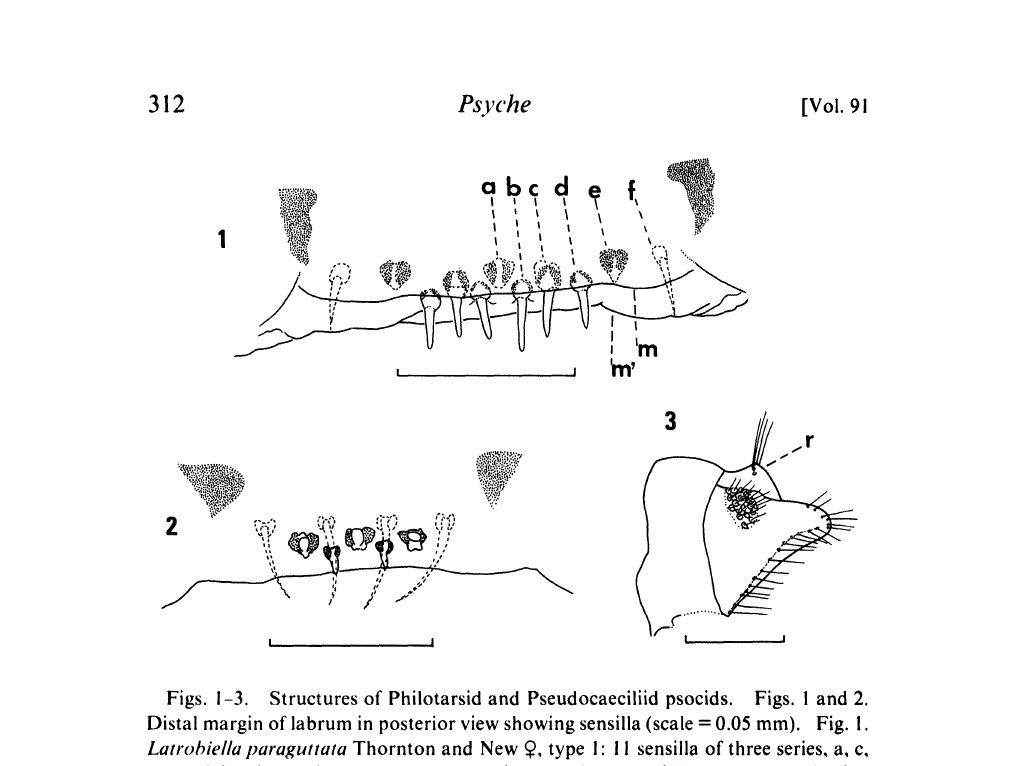
Figs. I-3. Structures of Philotarsid and Pseudocaeciliid psocids. Figs. and 2. , Distal margin of labrum in posterior view showing sensilla (scale 0.05 mm). Fig. I. Latrobiella paraguttata Thornton and New type I" 11 sensiila of three series, a, c, and e lying immediately under a posterior membranous fold (m), b and d lying deeper, perhaps on inner surface of second membranous fold (m’), and lying on anterior surface. Fig. 2. Zelandopsocus cumulus Thornton and New @, type 2: nine sensilla in two series, five shown in solid lines on posterior surface, four shown in dashed lines on anterior surface. Fig. 3. Zelandopsocus cumulus Q, clunium, epi- proct, and left paraproct in lateral view; setigerous ridge or flap of epiproct (scale 0.2